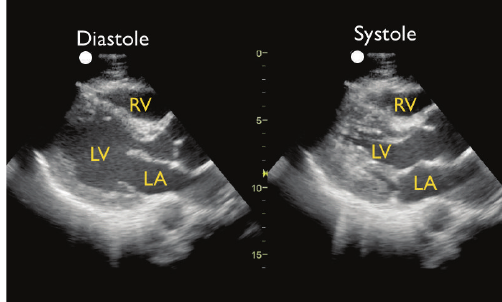
Figure 6: Good left ventricular contractility, parasternal long axis view. RV: right ventricle, LV: left ventricle, LA: left atrium.